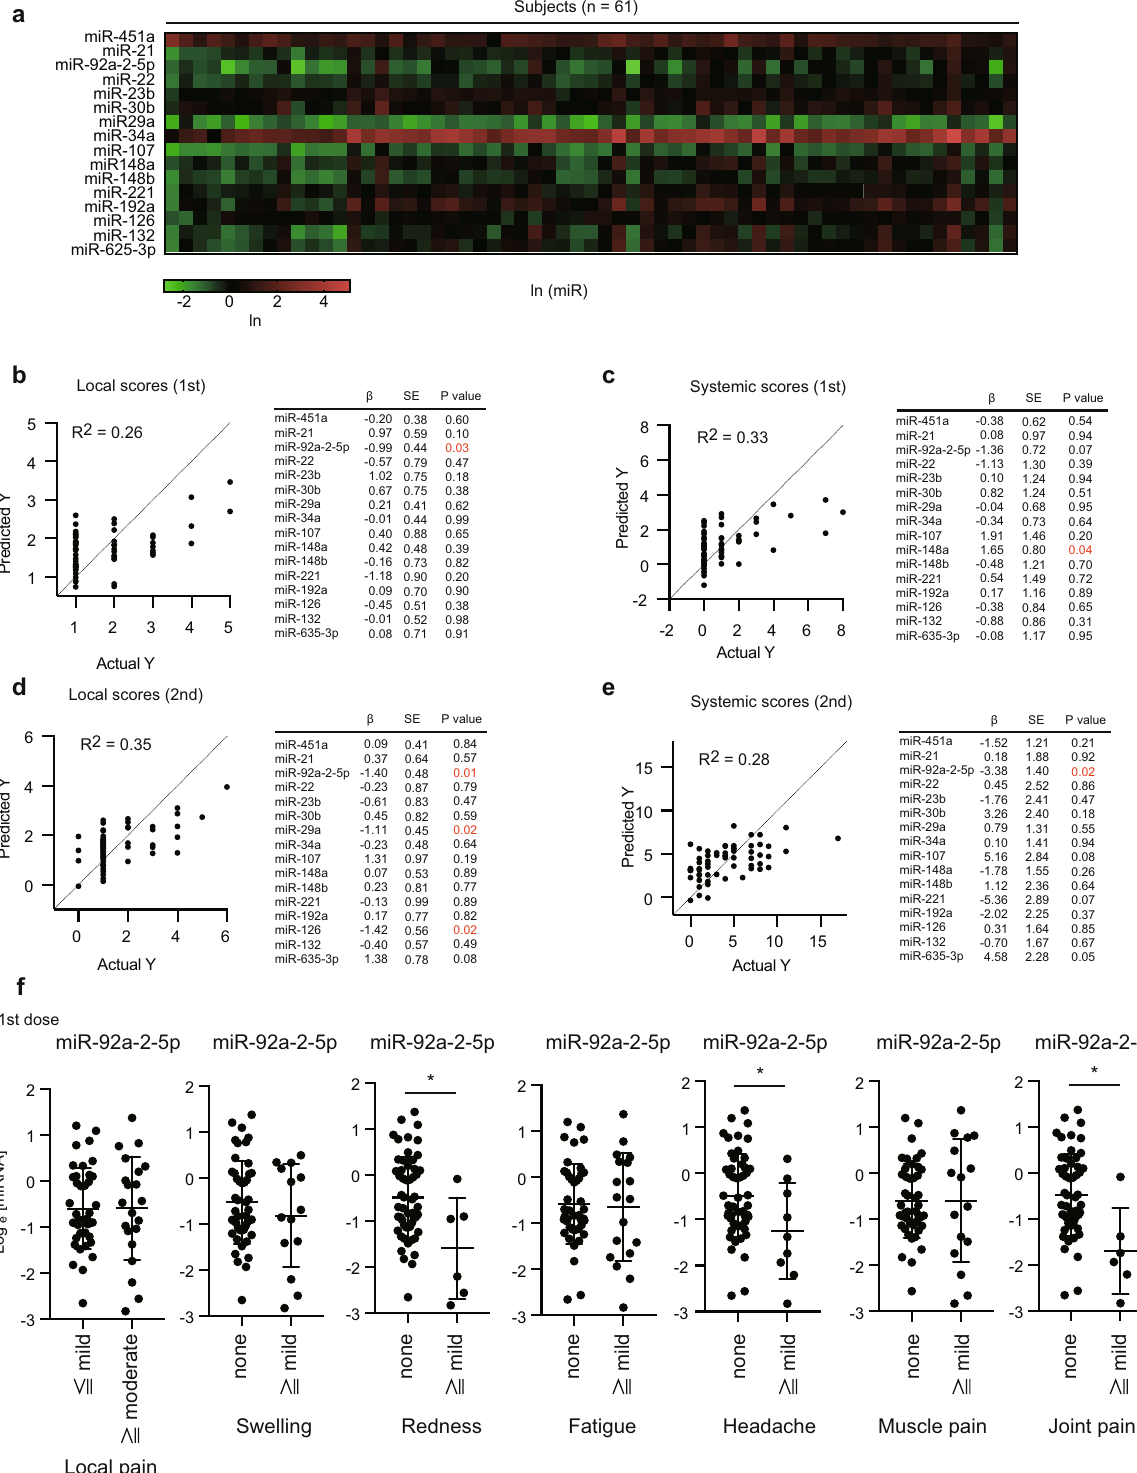
Fig. 6 Serum extracellular-vesicle miRNA levels. a EV miRNA levels in sera collected at 1 day before the fi rst dose were determined by RT- qPCR. The heatmap represents the ln (miRNA) values of each miRNA. b – e Local and systemic scores after the fi rst ( b , c ) and second ( d , e ) doses were compared with ln (miR) levels. Multiple linear-regression analyses were performed, and multiple coef fi cients of determination (R 2 ) were calculated. The tables show coef fi cient ( β ), standard error (SE), and p -values of each ln (miR). f All subjects were classi fi ed into two groups on the basis of the degree of each symptom as indicated. Ln (miR-92a-2-5p) levels in the two groups were compared. Student t -tests were performed (* p < 0.05). The bars represent mean ± SD. Each dot represents a